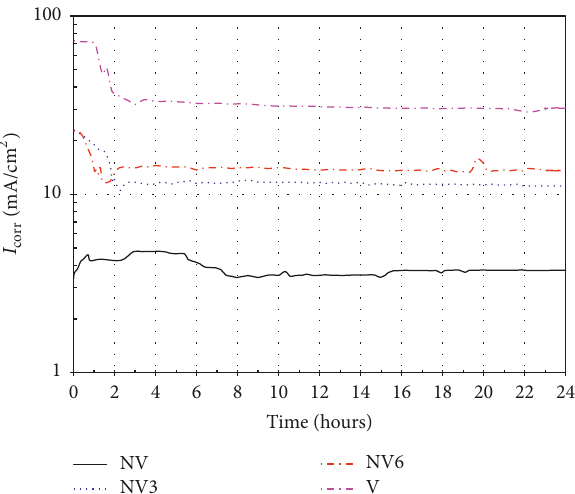
Figure 7: 𝐼 corr variation versus time for Ni in V-rich molten salts at 900 ∘ C.